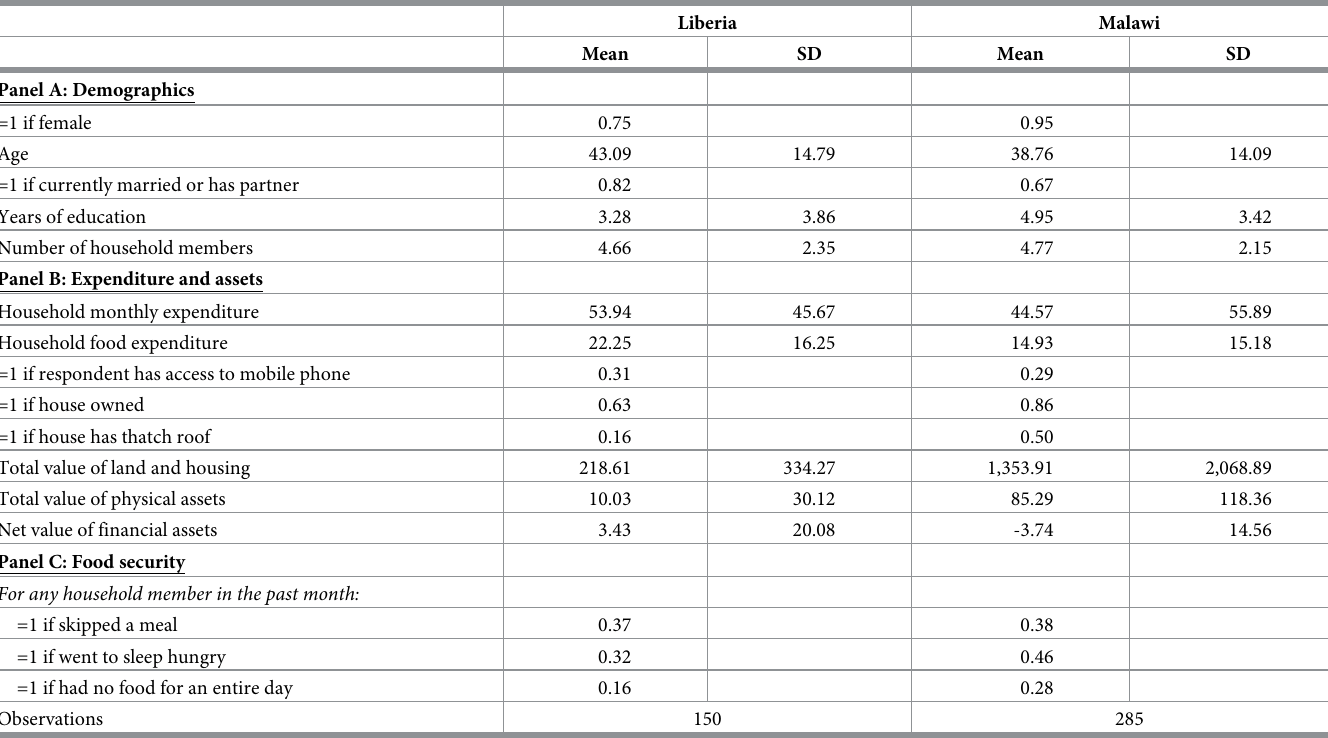
Table 1. Household summary